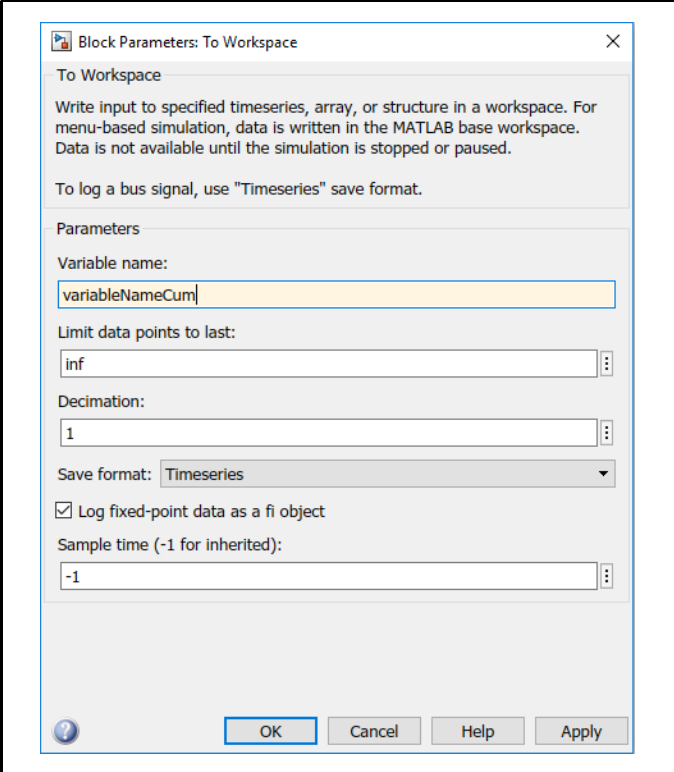
Figure A1. Customization of a Simulink block of type ToWorkspace.